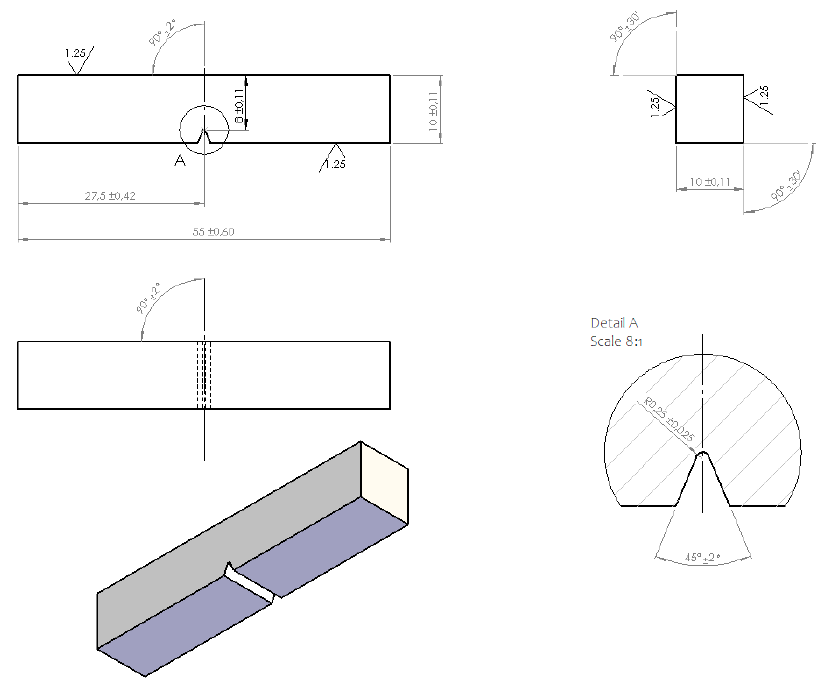
Figure 2. Charpy V-notch test sample geometry (dimensions in mm).